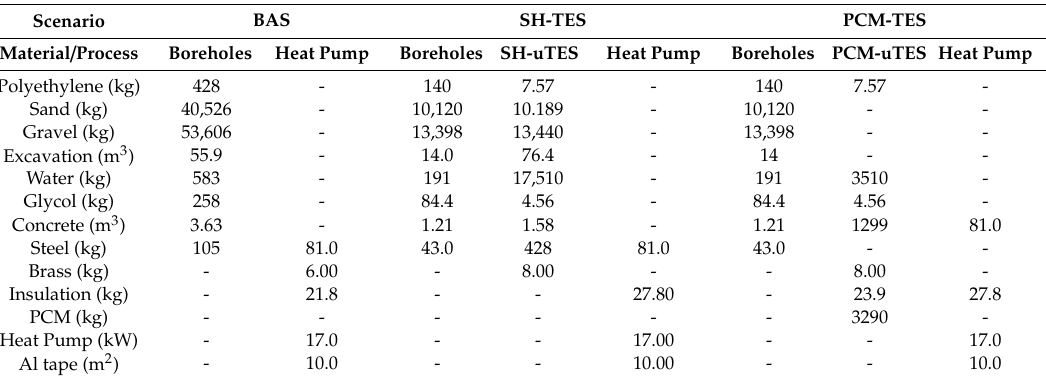
Table 2. Material inventory of each scenario.